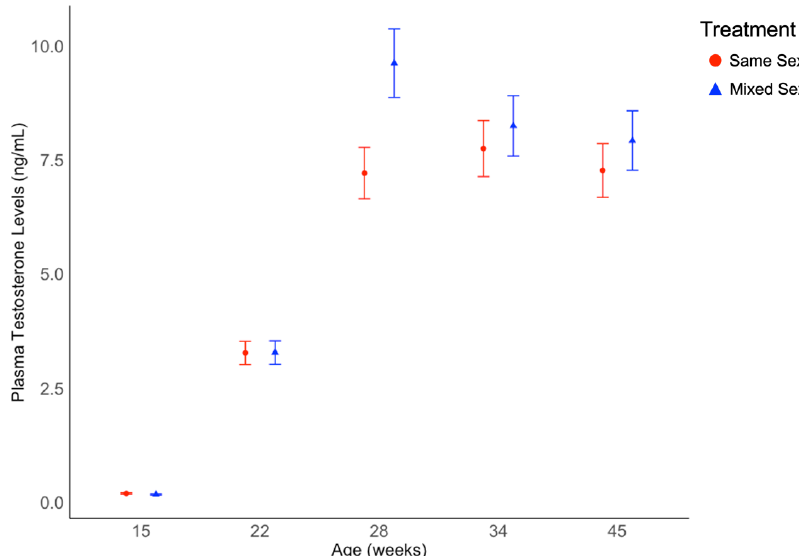
Figure 4. Circulating average testosterone concentrations in drake Pekin ducks from same sex rearing groups and mixed sex rearing groups from 15 to 45 weeks of age. Testosterone levels differed by age ( p < 0.001) but not treatment. Testosterone concentration values are back-transformed from a logarithmic transformation and presented as estimated marginal means and standard errors.